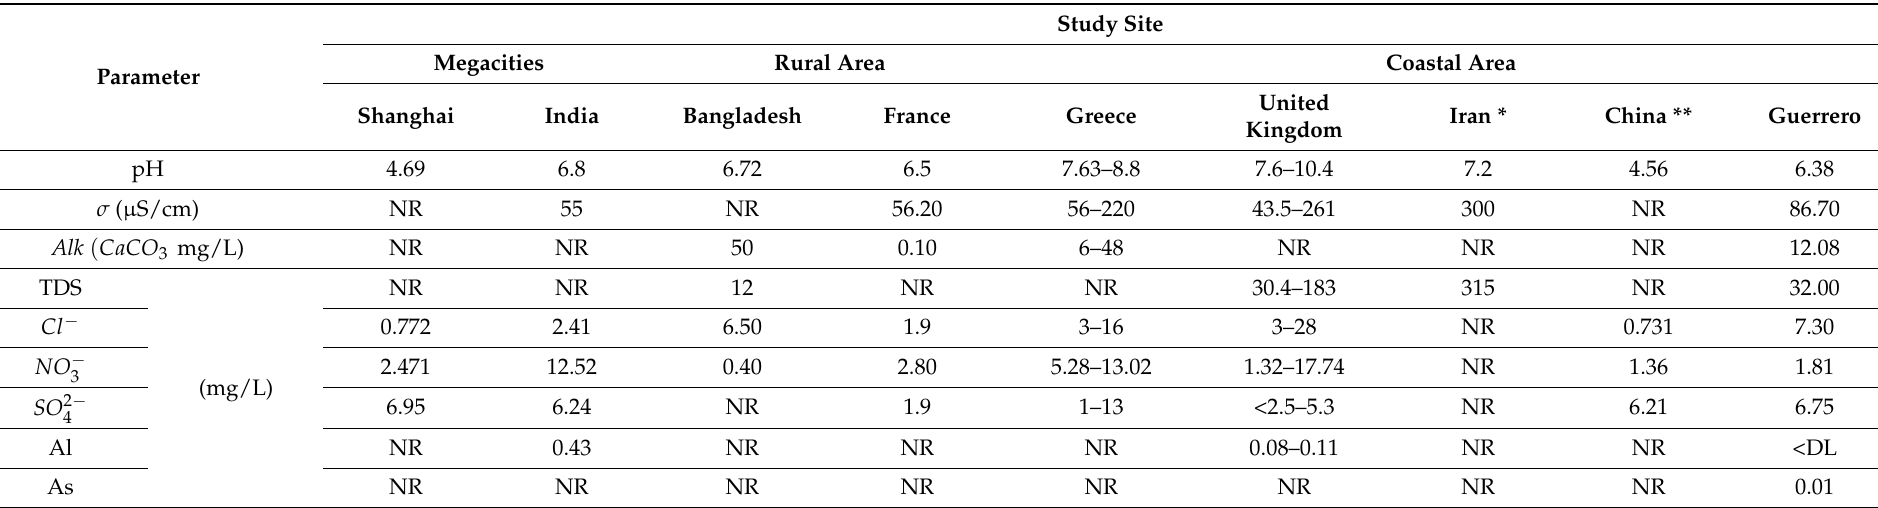
Table 5. Quality of rainwater harvested